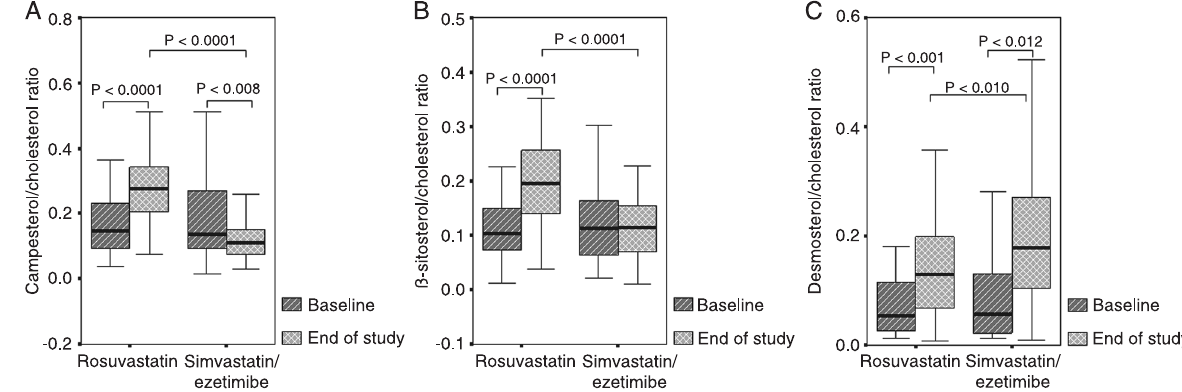
Figure 2. Box-plots (median, 25th and 75th percentiles) of the campesterol/cholesterol ( A ), β-sitosterol/cholesterol ( B ) and desmos- terol/cholesterol ( C ) ratios at baseline and at the end of the study according to treatment. Baseline values were comparable between groups. Rosuvastatin increased all of these ratios (P < 0.002 vs baseline for all, Wilcoxon test). Treatment with simvastatin/ezetimibe promoted a significant decrease of the campesterol/cholesterol ratio (P = 0.008 vs baseline, Wilcoxon test), but not of the β-sitosterol/ cholesterol ratio (P = NS). Conversely, the desmosterol/cholesterol ratio increased 3-fold after treatment with simvastatin/ezetimibe (P < 0.0001). Comparison of the effects of treatments showed that campesterol/cholesterol and β-sitosterol/cholesterol ratios were lower at the end of treatment in patients receiving simvastatin/ezetimibe than in those treated with rosuvastatin (P < 0.0001, Mann-Whitney test), whereas the desmosterol/cholesterol ratio was higher in patients treated with simvastatin/ezetimibe (P <